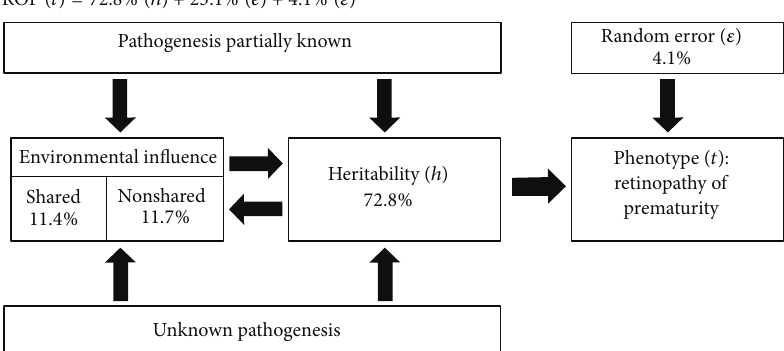
Figure 1: The pathophysiology of ROP is dynamic, influenced by genetic, environmental, and random factors. 𝜀 , random error; 𝑡 , ROP phenotype; ℎ , heritability; 𝑒 = environmental